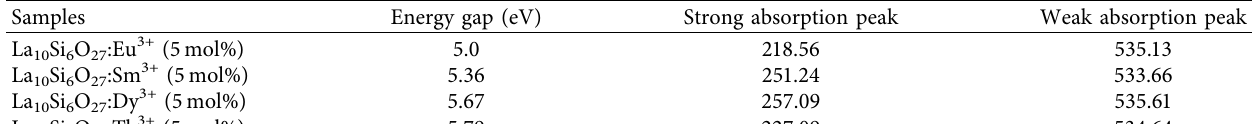
Table 2: Estimated energy gap (eV) of La